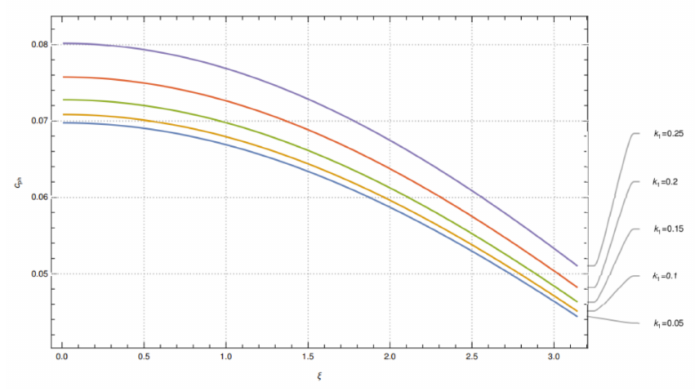
Figure 11. The change in phase velocity at different concentrations.